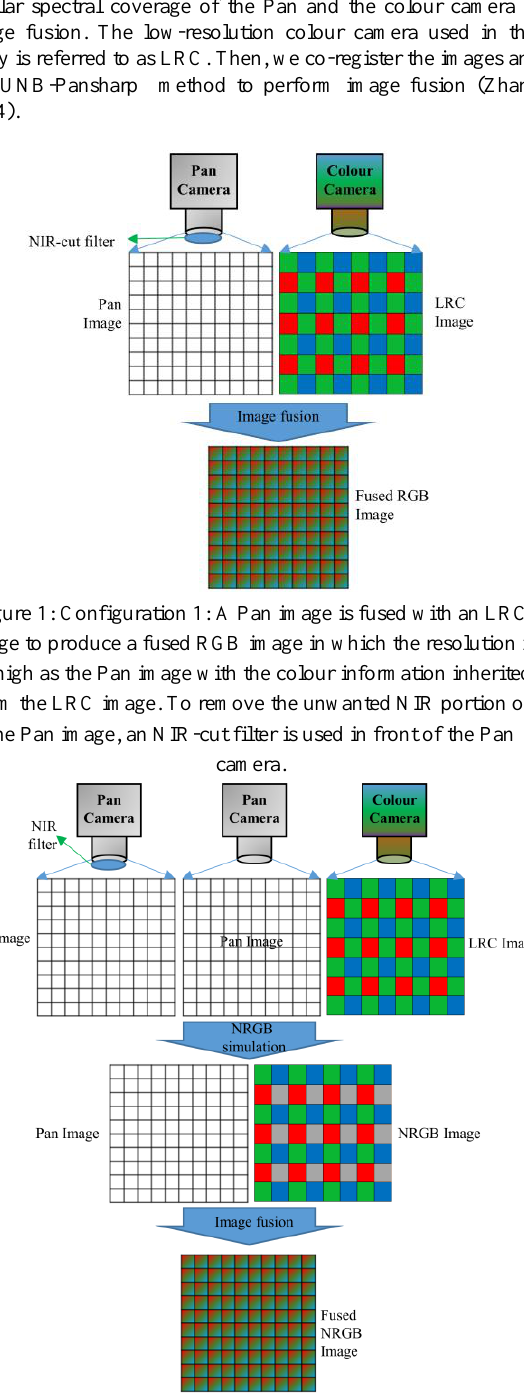
Figure 2: Configuration 2: A Pan image is fused with a simulated NRGB image to produce a fused NRGB image in which the resolution is as high as the Pan image with the